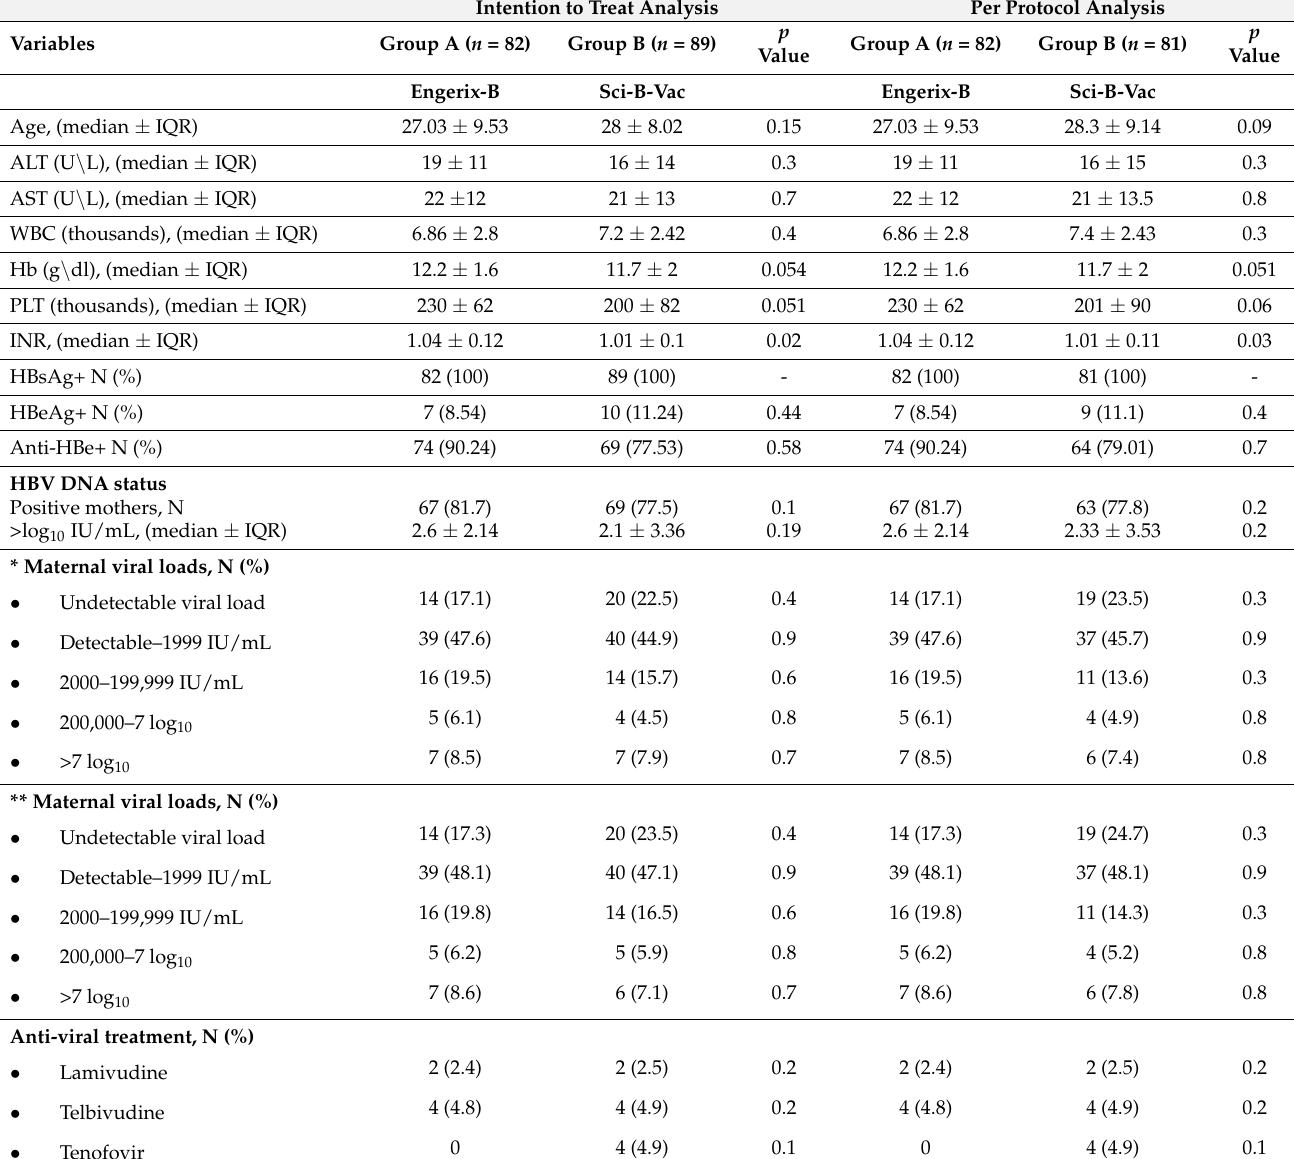
Table 1. Baseline maternal laboratory results at the delivery room. Intention to Treat Analysis Per Protocol